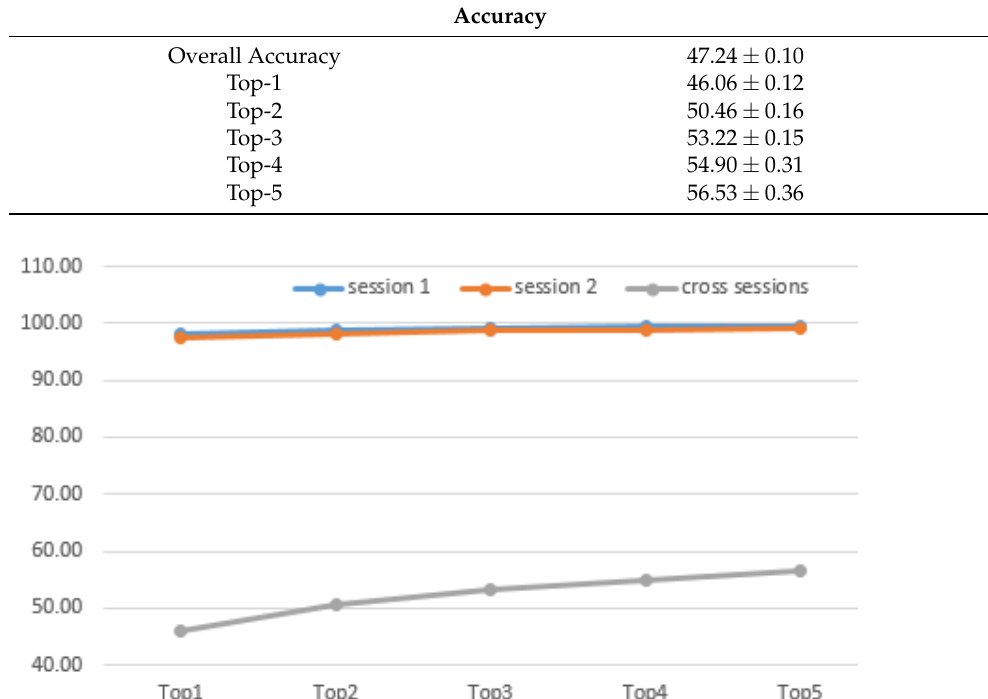
Figure 6. Comparison between the top-k accuracy of the proposed system showing three different experiments i.e., session1, session 2, and cross sessions.